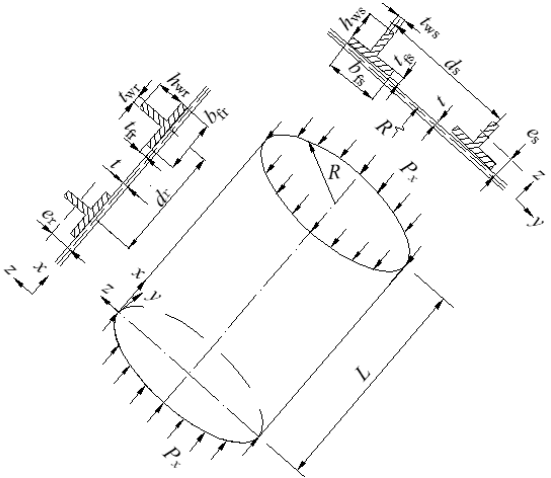
Figure 2. Configuration of an eccentrically stiffened cylindrical shell.